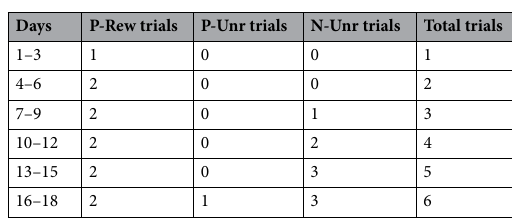
Table 1. Training timeline, with the number of rewarded P trials (P-Rew), unrewarded P trials (P-Unr), and unrewarded N trials (N-Unr) per cow in each consecutive three-day block.